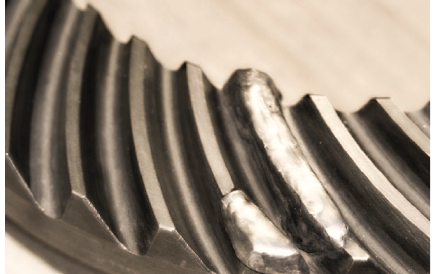
Figure 2: Example of emergency repair of the cogwheel by